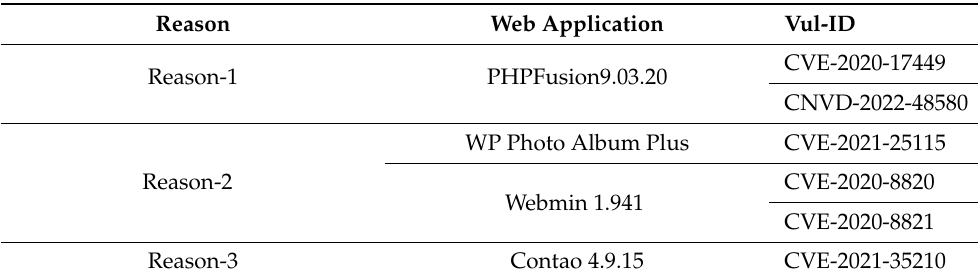
Table 8. Statistics of Black Widow Undetected Vulnerability